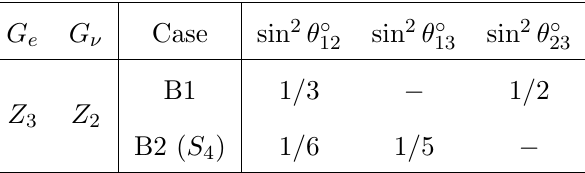
Table 5 . Values of the (cid:12)xed parameters sin 2 (cid:18) (cid:14) to the residual symmetries G e and G (cid:23) , as derived in ref. [20] (see also ref. [21]). The entries marked with \ " are not relevant. (cid:0)